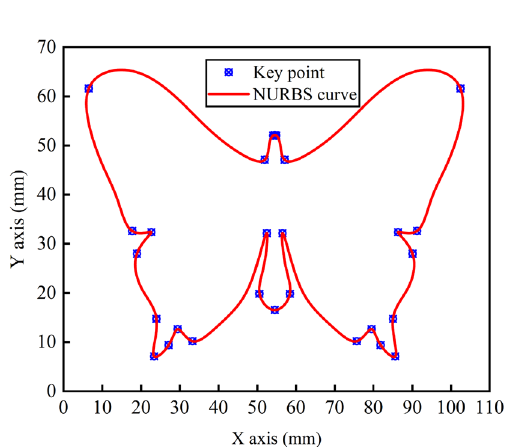
Figure 7. Key point.